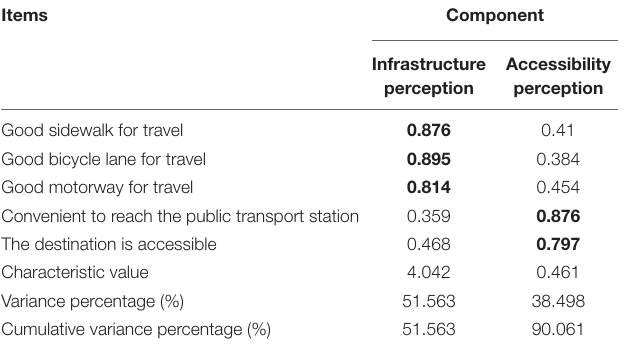
TABLE 7 | Multicollinearity test.